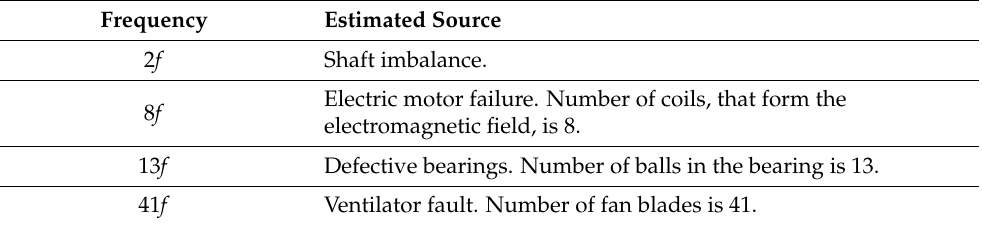
Table 1. The list of elementary functions that describe the pure nature of HVAC along with their estimated sources.